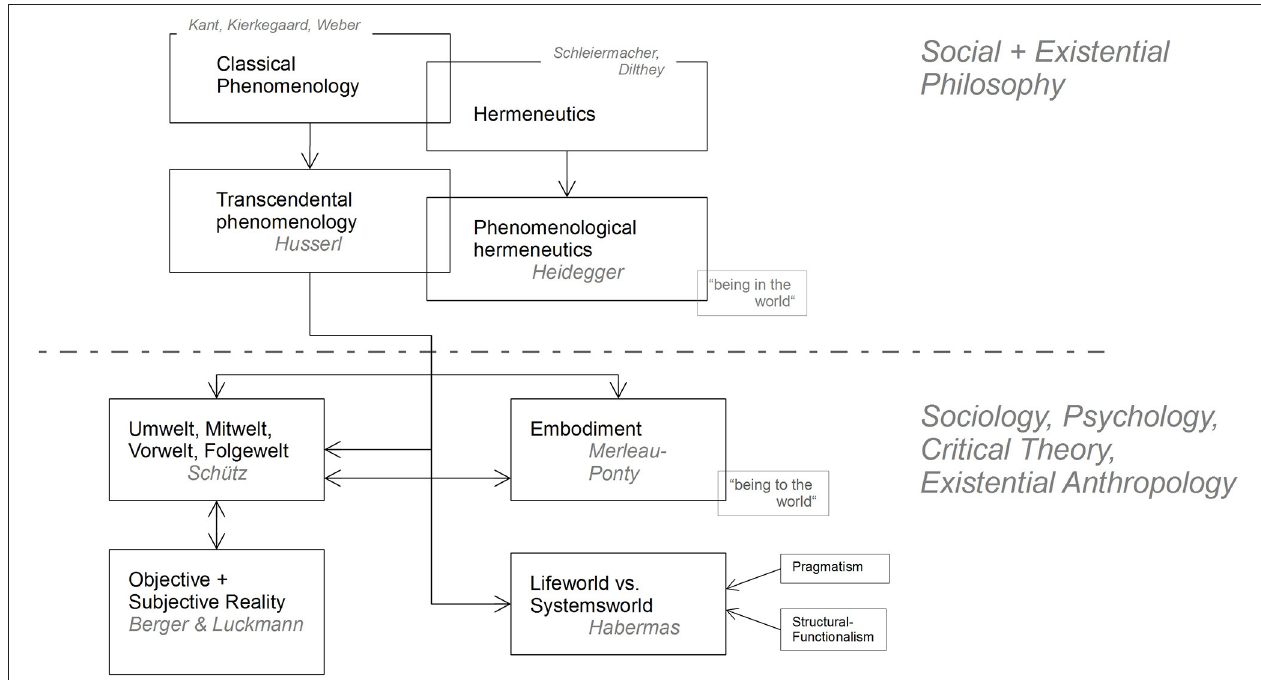
FIGURE 1 | The Building blocks of the Lifeworlds concept. The chart aims at establishing clarity, yet does not make the claim of being exhaustive or non-expansive. Nor does it claim to holistically represent the diverse ontological and epistemological currents that influenced the foundational theorists